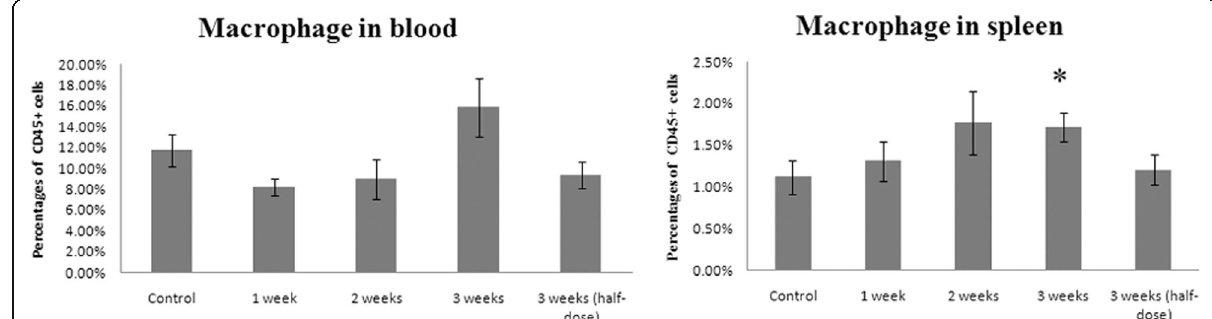
Fig. 4 Statistic results of macrophage cells in blood and spleen. The time and dose treatment of modified Si-Jun-Zi Decoction was labeled under the columns. The data were shown as mean ± standard error of mean. *: P < 0.05 compared with control group by student t